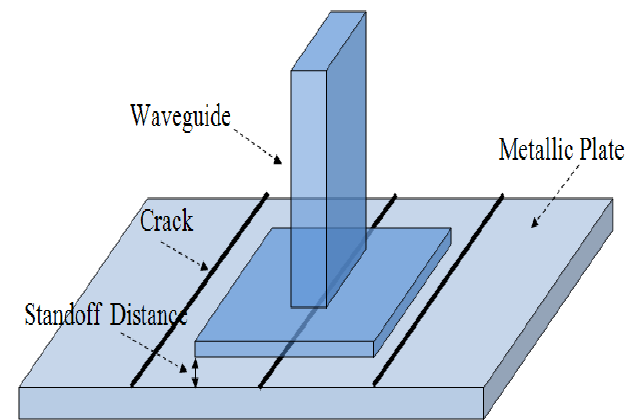
Figure 1. Schematic drawing of a waveguide sensor scanning a metallic plate with surface cracks.